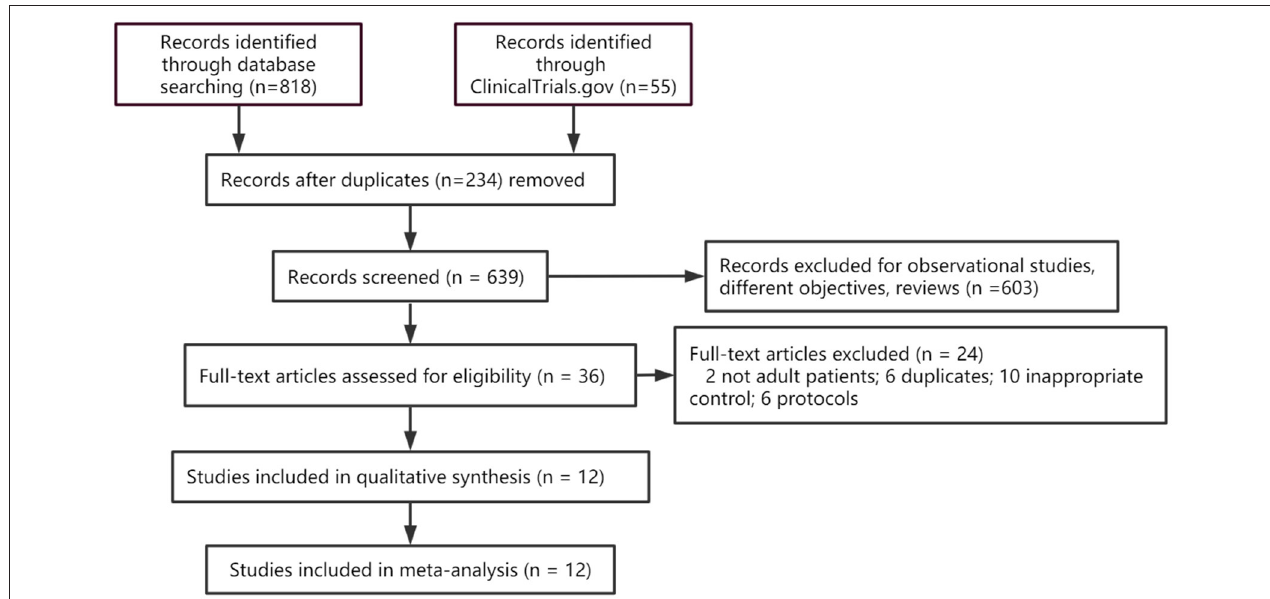
FIGURE 1 | PRISMA flow diagram showing study selection. RCT, Randomized controlled